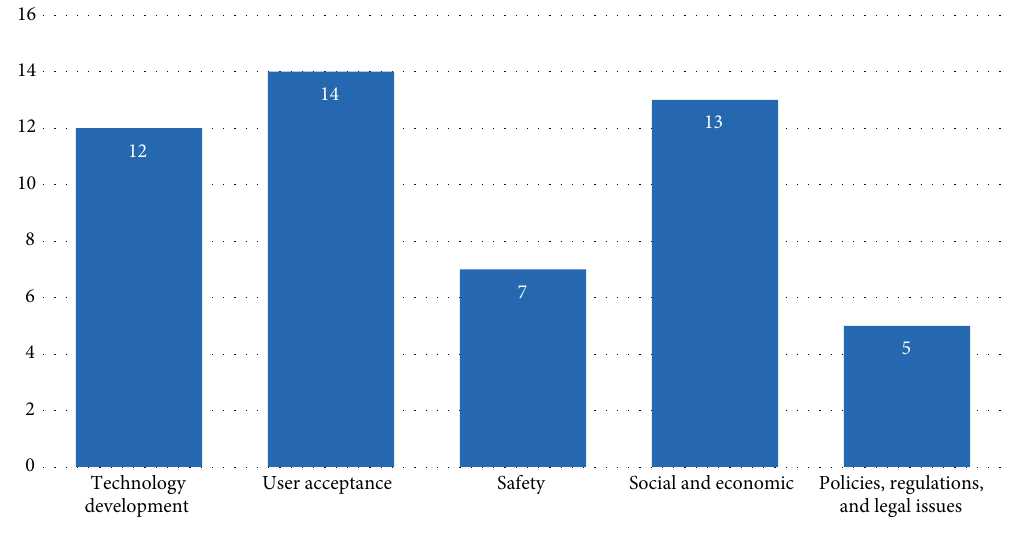
Figure 4: Number of reviewed studies in each theme ( 𝑛 = 40 ; some studies counted multiple